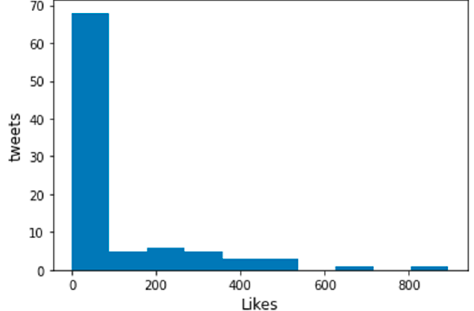
Figure 7. Non-buzz tweet like distribution.